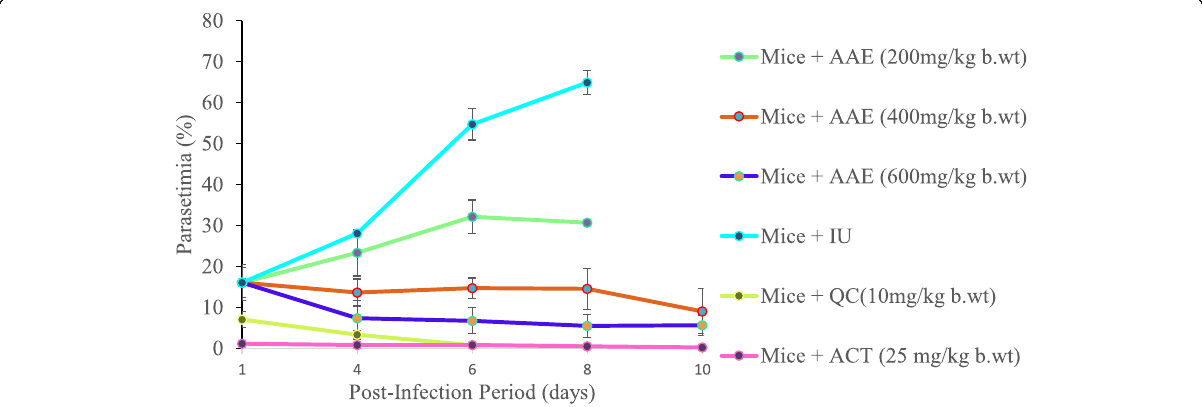
Fig. 1 Effects of Aqueous extract of A. aspera shoot on the parasitemia level of mice infected with P. berghei (NK-65). Mice + AAE = infected mice treated with Achyranthes aspera aqueous extract, Con IU = infected mice untreated, Con CQ = infected mice treated with chloroquine (10 mg/ kg), Con ACT = infected mice treated with artemisinin (25 mg/kg) and NC = normal control